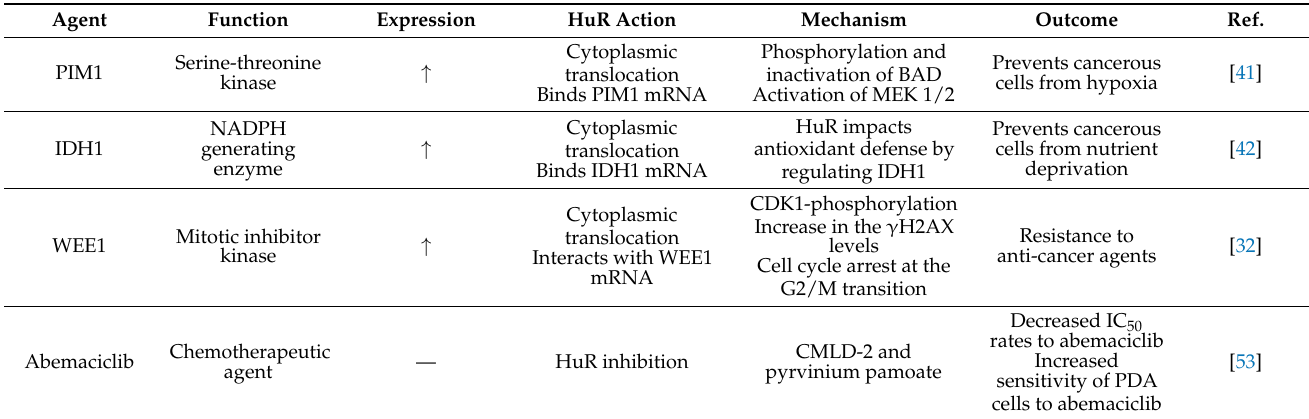
Table 1. Agents interacting with HuR in a posttranscriptional level and their therapeutic